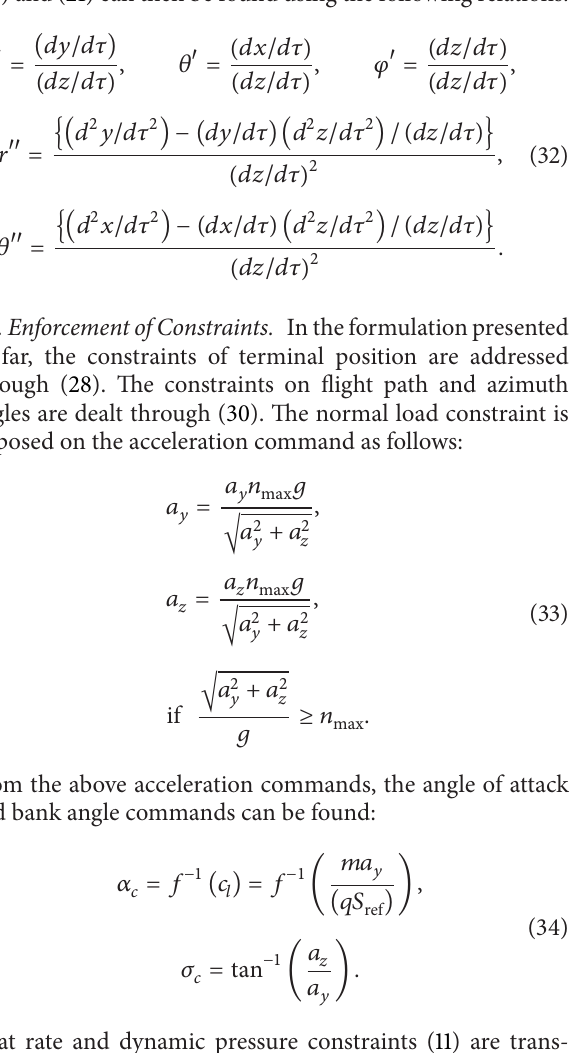
the figure, 𝑃 𝑚 is the intersection point of the tangent lines 𝑃 𝑃 𝑃 𝑃 0 𝑚 and 𝑓 𝑚 . Representation of B´ezier parameter ratio of (𝑃 1 − 𝑃 0 ) and (𝑃 𝑚 − 𝑃 0 ) facilitates sliding of 𝑃 1 on the tangent line 𝑃 𝑚 𝑃 0 with changing values of 𝑘 1 . Thus, if only 𝑘 2 is changed, control points 𝑃 0 , 𝑃 1 , 𝑃 𝑓 and tangent lines 𝑃 0 𝑃 𝑚 and 𝑃 𝑓 𝑃 𝑚 stay unchanged in their position and